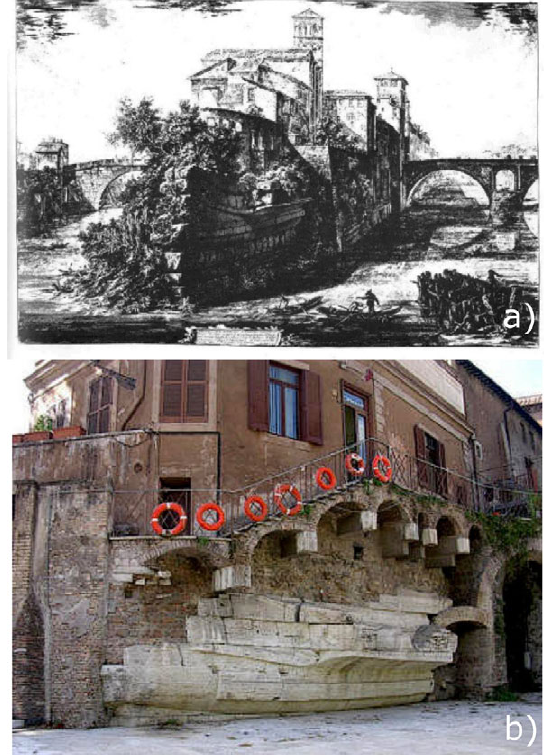
Fig. 4. Tiberina Island geomorphosite, Rome, an example of landform